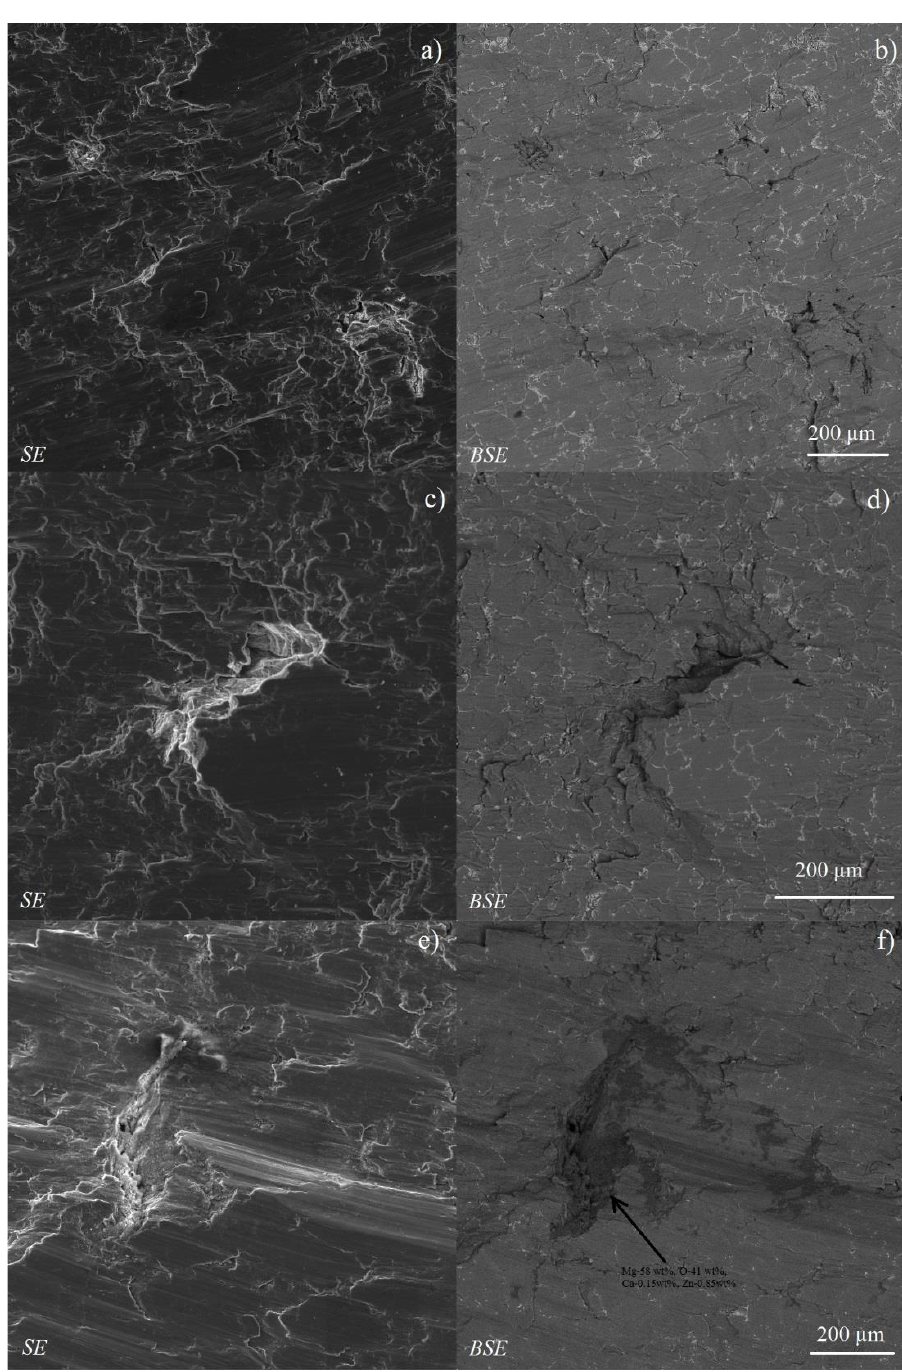
Figure 7. SEM image of the fracture surface of magnesium alloys Mg–Ca–Zn reference ( a , b ), Mg–Ca– Zn–ND ( c , d ), and Mg–Ca–Zn US ( e , f